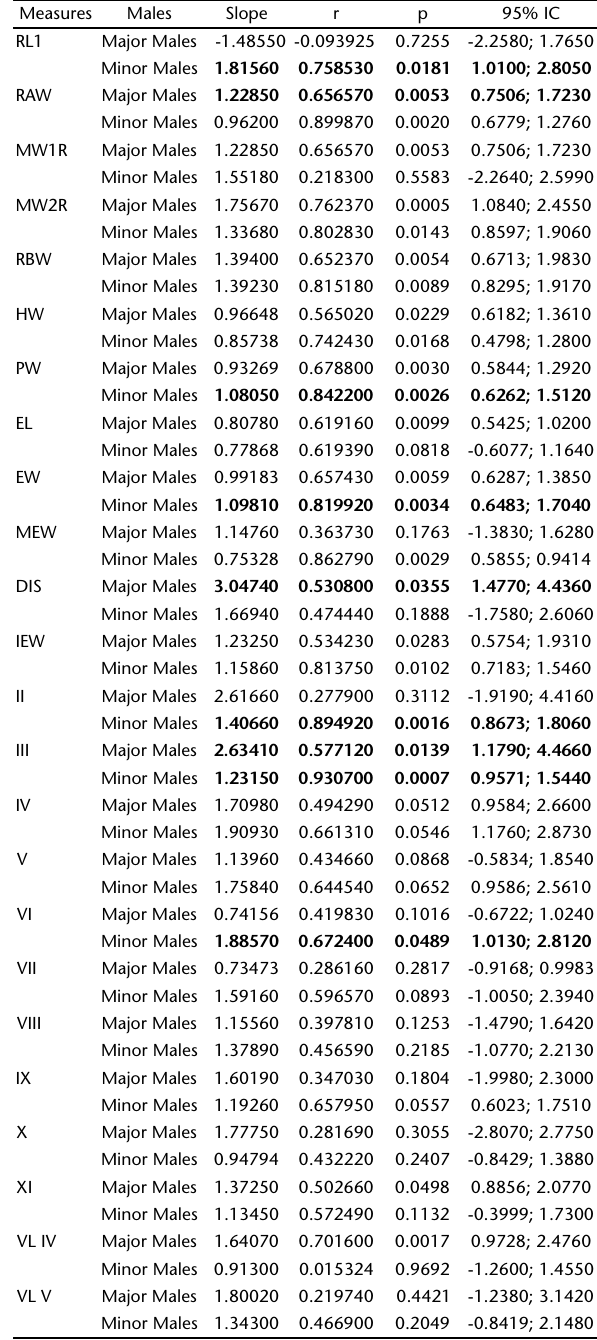
Table III. The results based on regression. Reduced Major Axis regression (RMA) of pairs of morphological variables selected with positive allometry in S. platyrhinus . Prothorax length (PL) was used as a predictor variable, and all variables were log-transformed prior to the two male groups (major and minor). Values of positive allometry shown in bold, with slope >1 and p (cid:2)